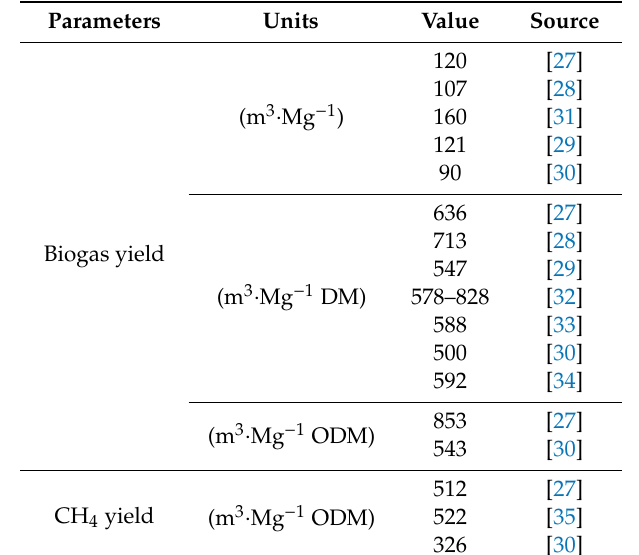
Table 1. Biogas and CH 4 yield from